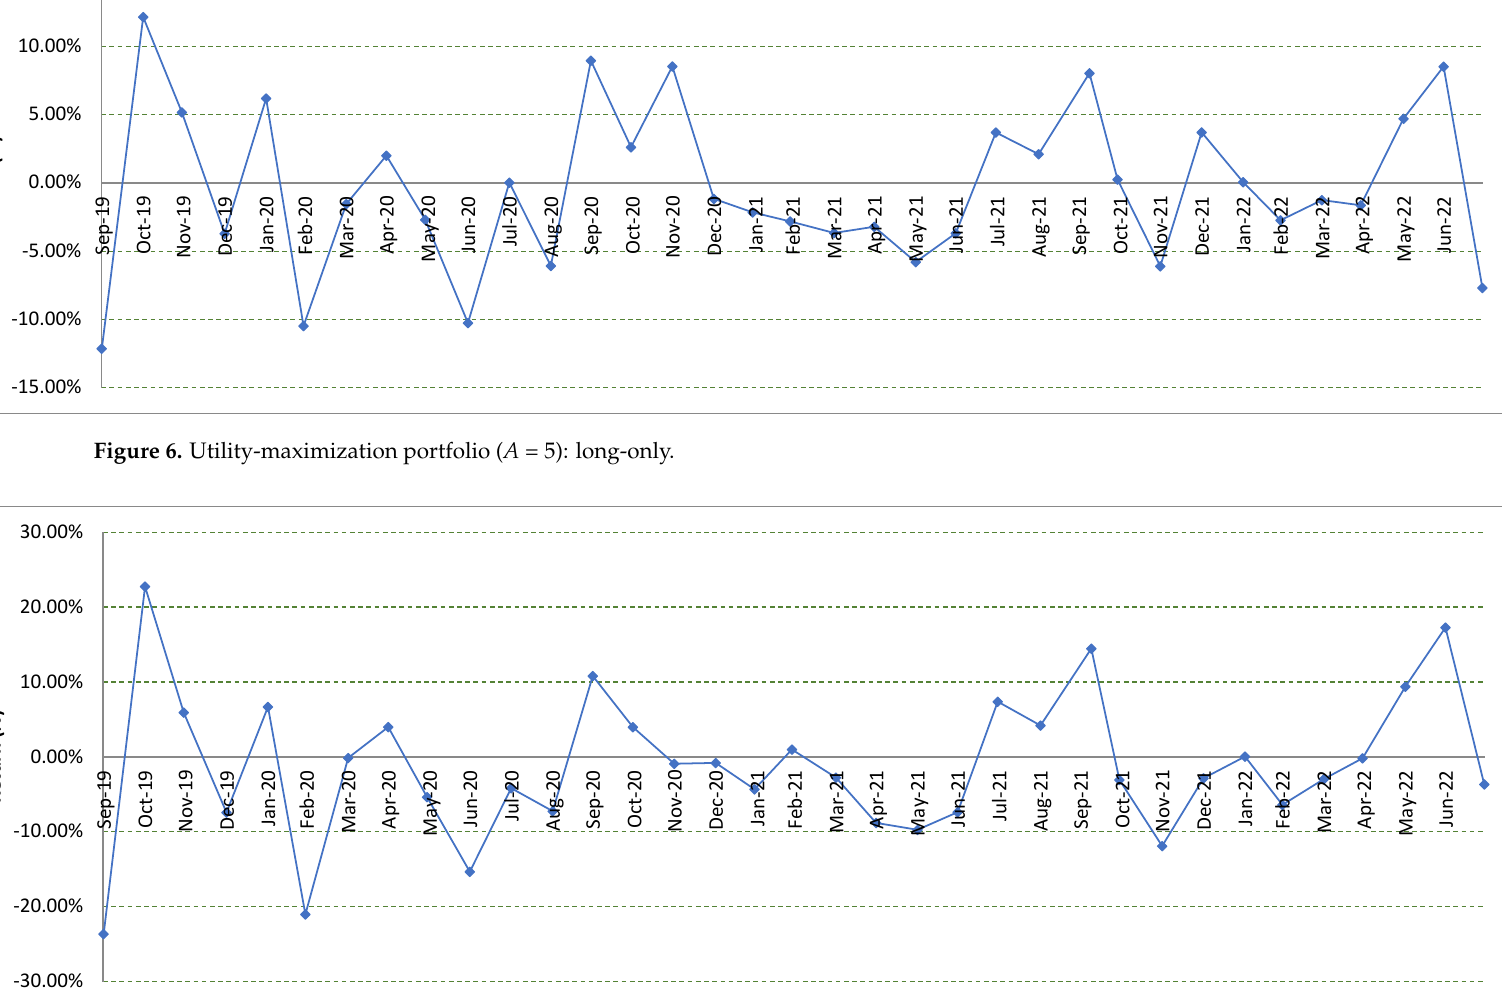
Figure 7. Utility maximizing portfolio ( A = 2):